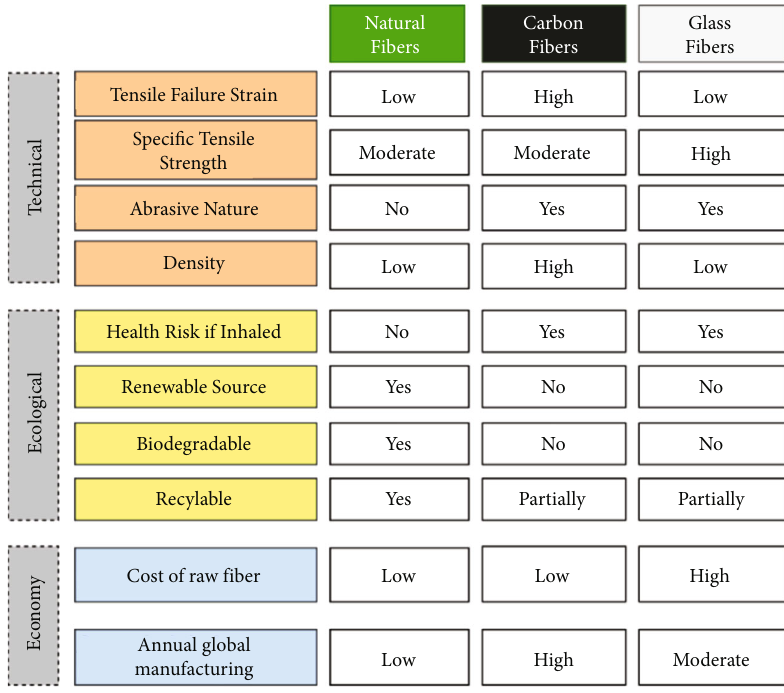
Figure 1: Ecological, technical, and economical di ff erences between natural and man-made synthetic fi bres.